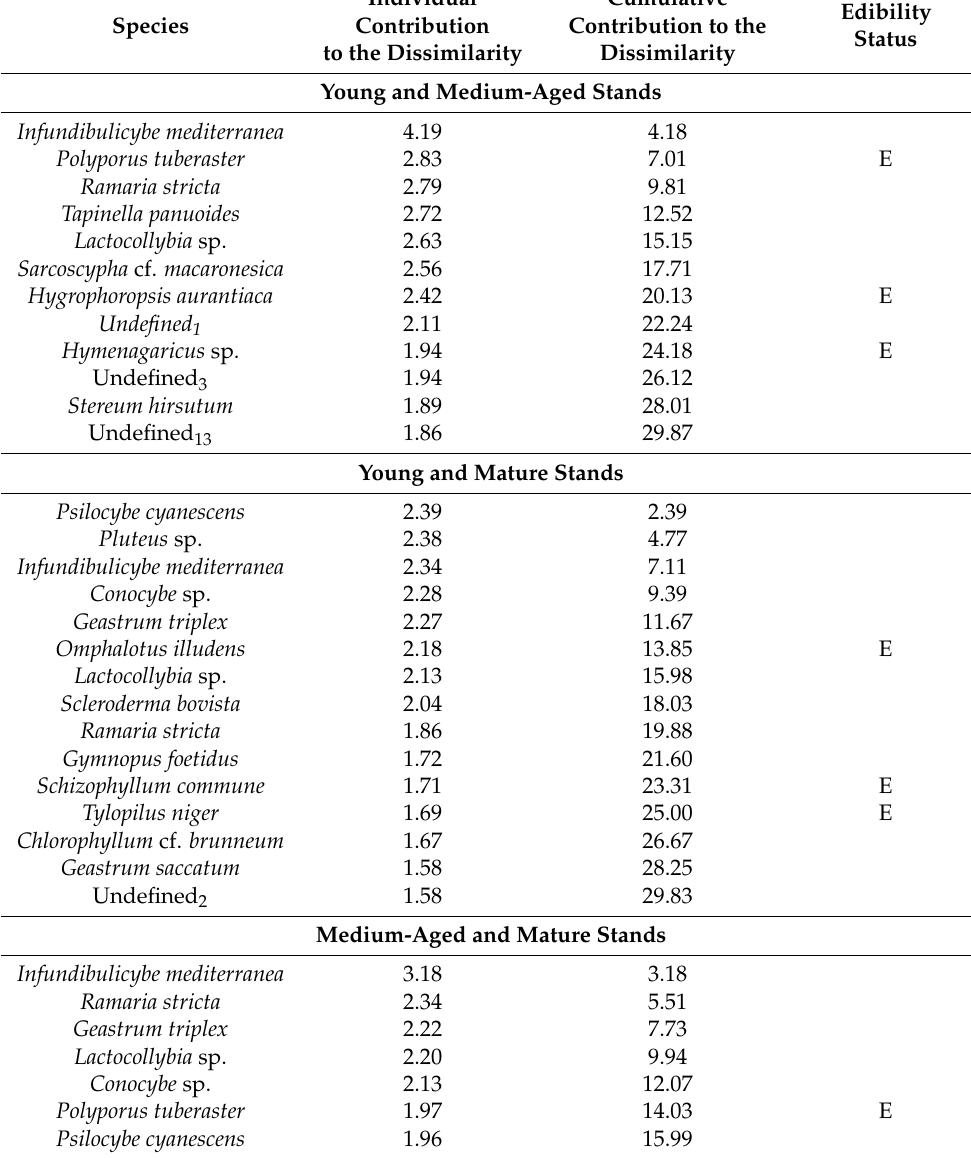
Table 5. Summary of similarity percentage (SIMPER) results based on Bray–Curtis measures showing the cumulative total contribution (30% cut-off) and the contribution (%) of the most influential species to the dissimilarity between the young, middle-aged, and mature Pinus radiata stands in Menagesha Suba, central Showa, Oromia National Regional State,